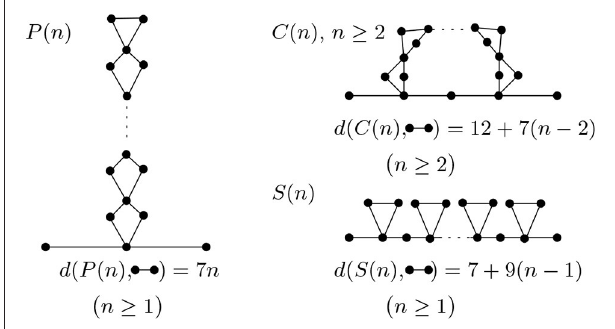
FIGURE 8 | Parallel, cross, and series arrangement in the case of n contacts. With each contact we add, the complexity increases and is detected by the graph edit